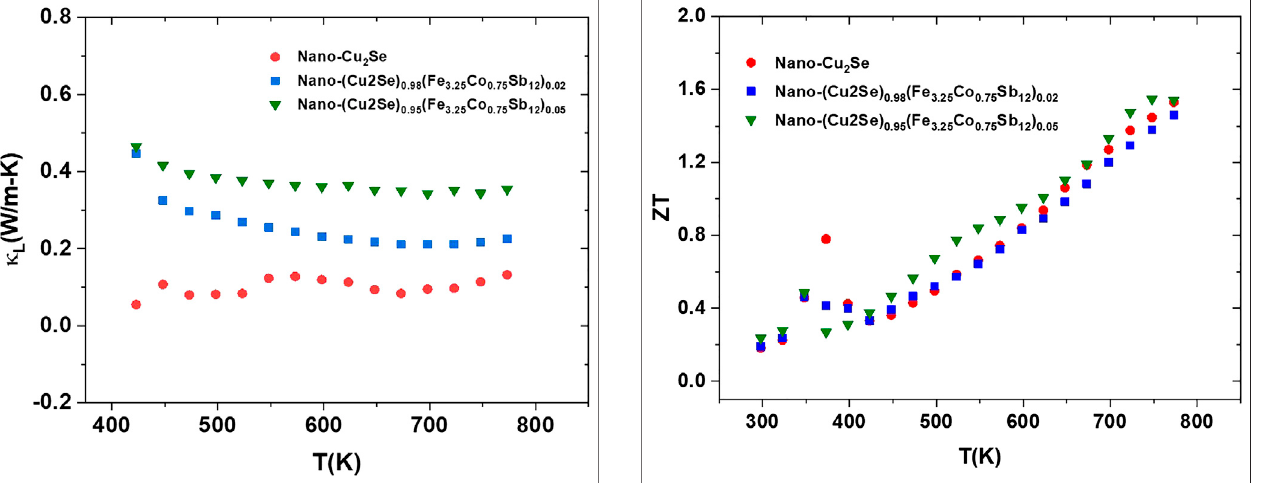
L , vs. temperature for